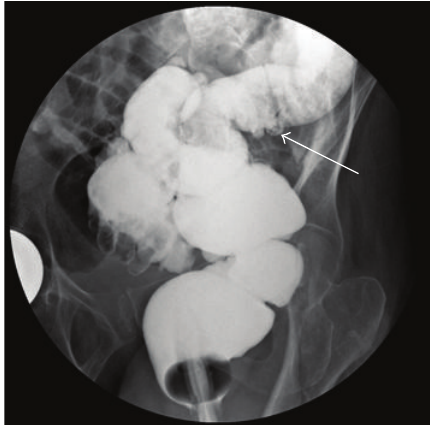
Figure 2: Barium enema showing diverticulosis (marked by arrow) but no signs of sigmoidal obstruction.